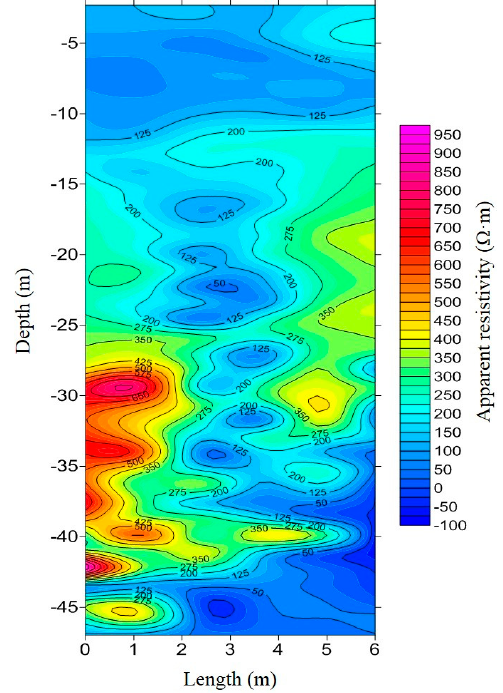
Figure 4. Apparent resistivity contour cross-section [26].